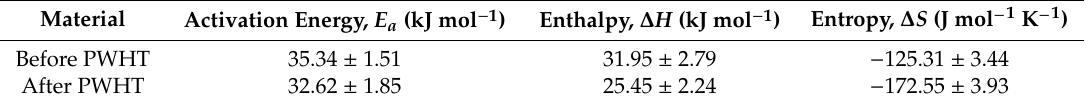
Table 4. Activation parameters for butter weld samples before and after the